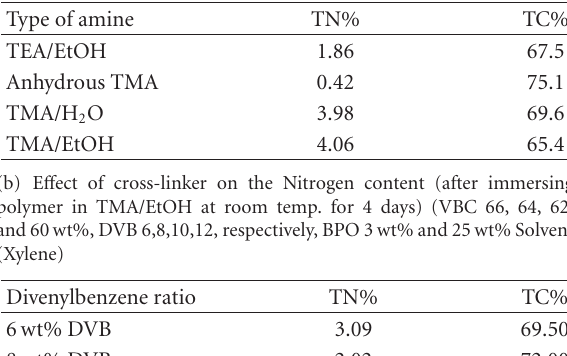
Table 1: Carbon and nitrogen analysis for the various experimental runs. (a) E ff ect of Functionalization agent on the amount of Nitrogen in polymer (after immersing polymer in TEA/EtOH, anhydrous TMA, aqueous TMA and ethanolic TMA at room temp. for 4 days). (VBC 66wt%, DVB 6wt%, BPO 3wt% and 25wt% Solvent (Xylene)